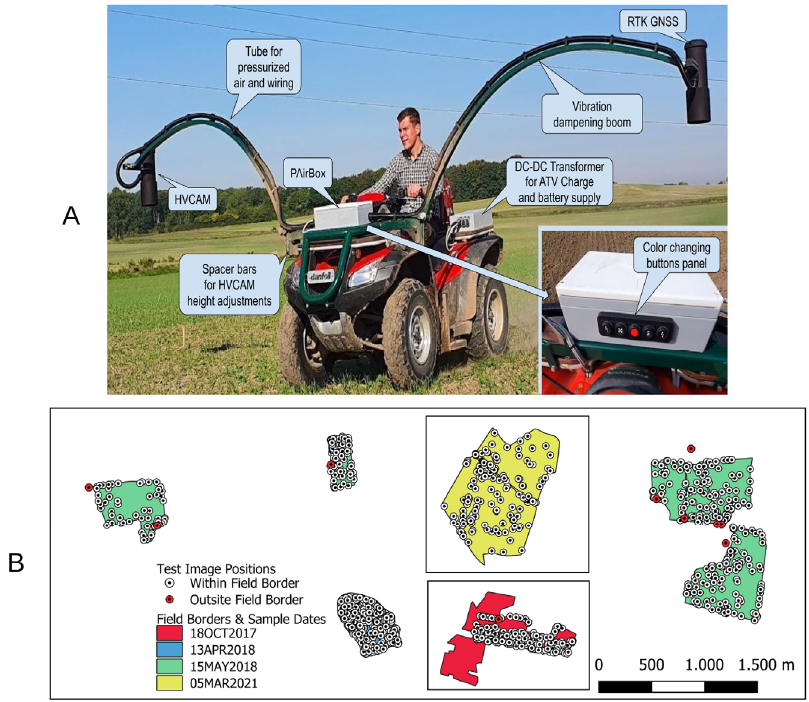
Figure 1. ( A ) The recording setup used HVCAM to collect both the training and test images; ( B ) the in-situ images collected from 10 different fields across Denmark as test set.